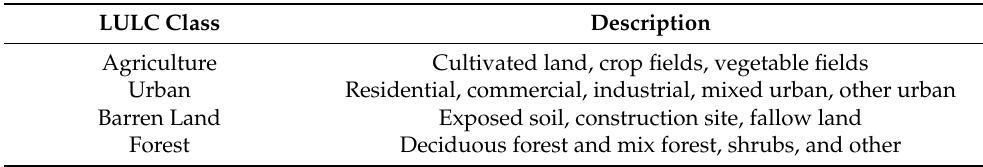
Table 3. Description of land-use and land-cover classes used in this study.